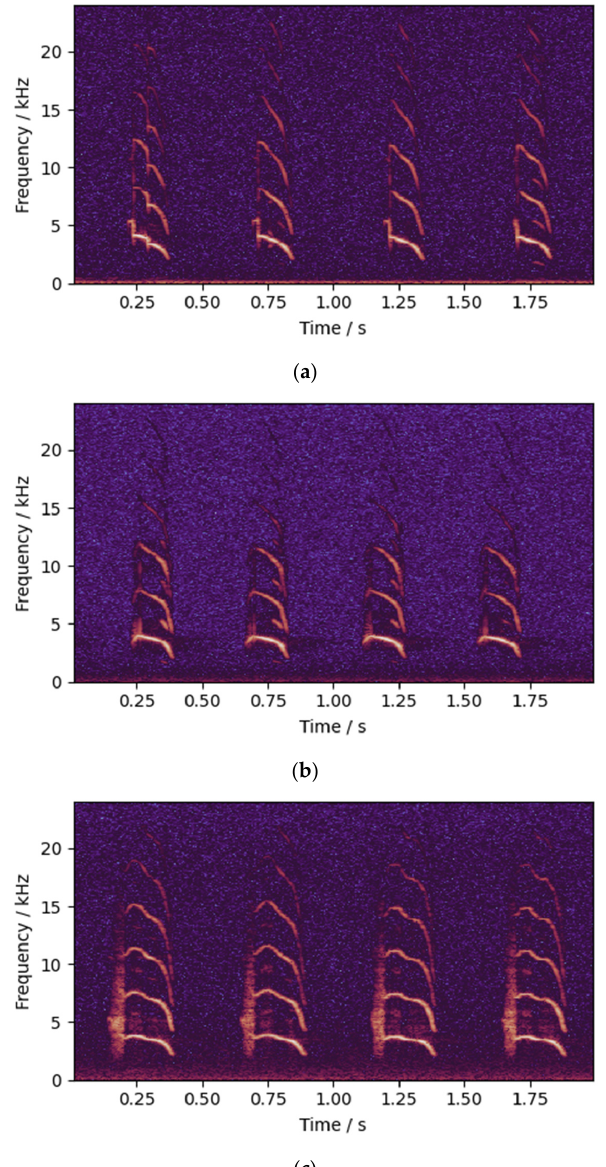
Figure 1. Spectrogram of chicks’ calls: ( a ) three yellow chicken; ( b ) flaxen-yellow chicken; ( c ) and native chicken.